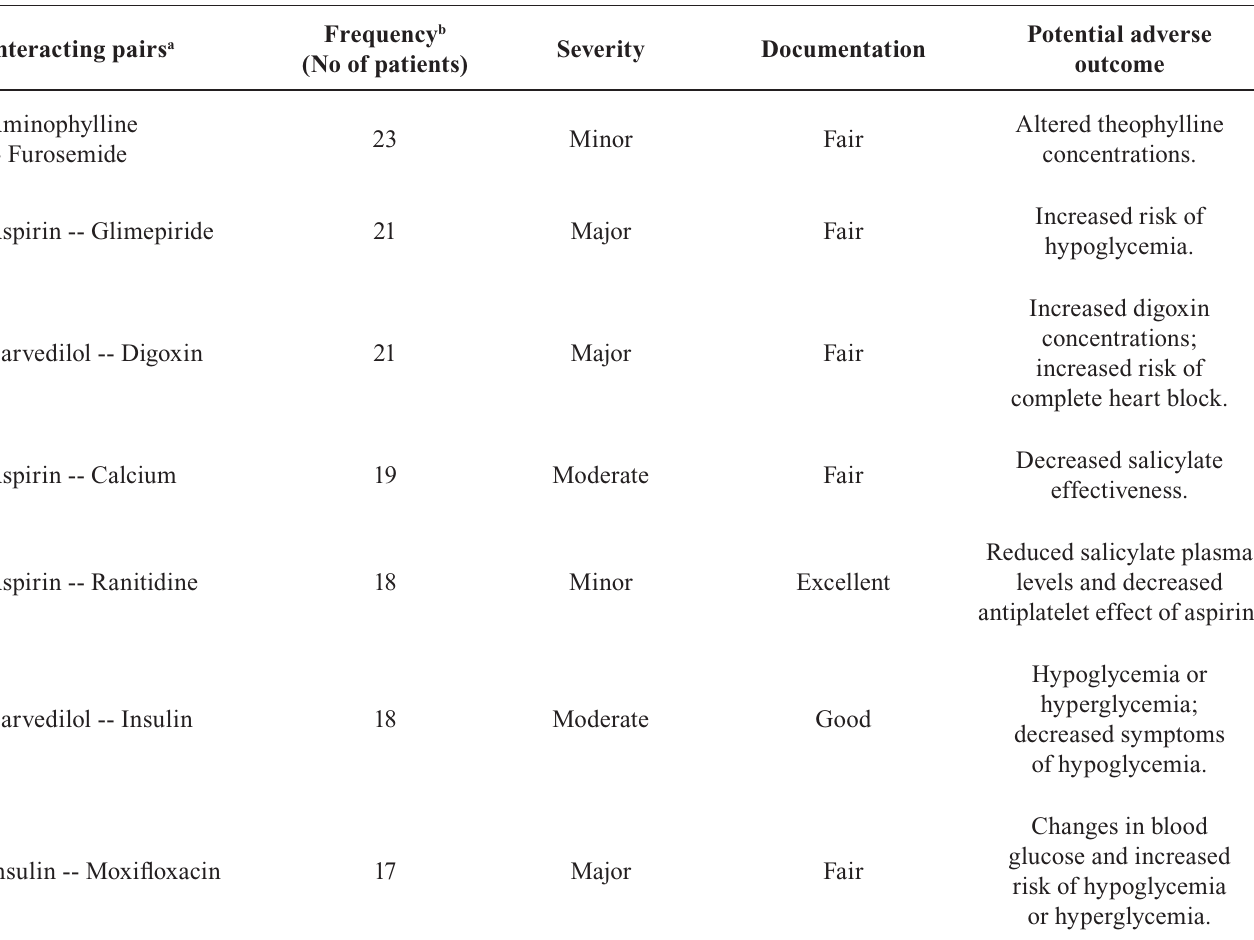
TABLE V - Most frequently identified interactions, their levels and potential adverse outcome